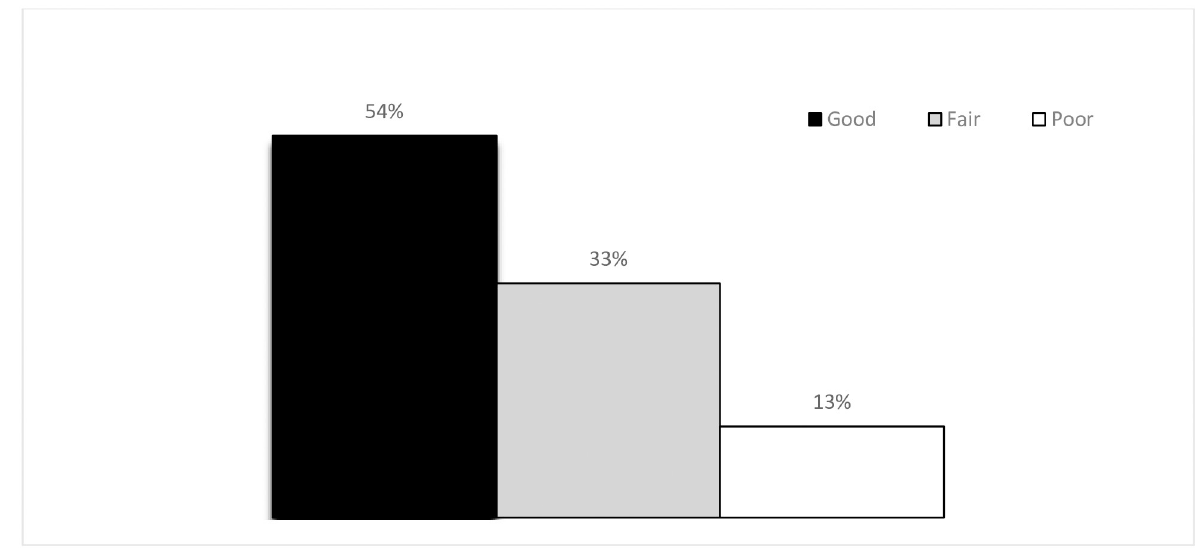
Fig 1. Knowledge of risk factors among CVD patients attending chronic follow up care.